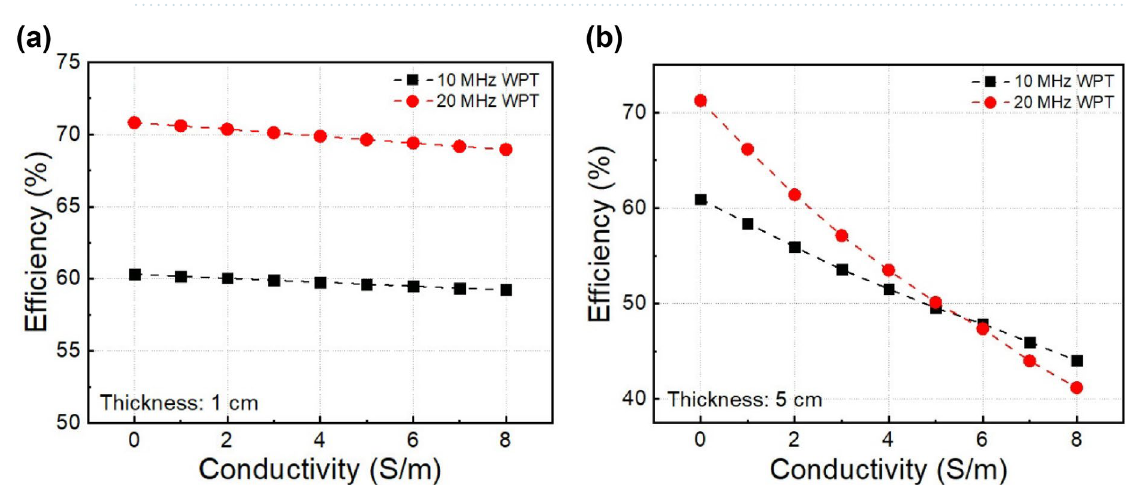
Figure 8. Measured transfer efficiency of two MR-WPT systems as a function of conductivity, (a) conducting block thickness of 1.0 cm, (b) conducting block thickness of 5.0